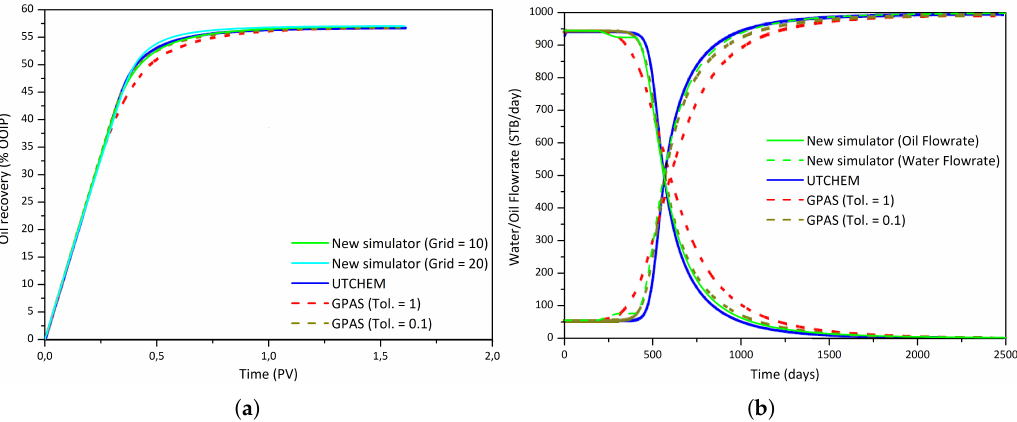
Figure 4. Oil recovery ( a ) and flowrates (in Standard Barrels per day— b ) during a secondary recovery, comparing the results with UTCHEM and GPAS (Adapted from Najafabadi